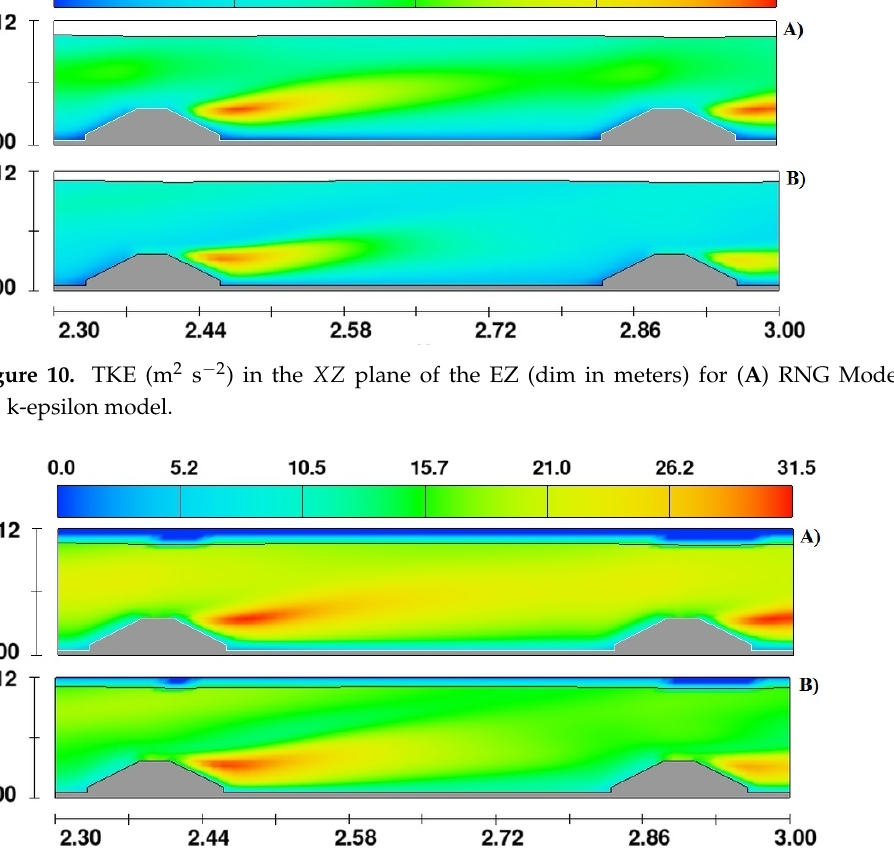
Figure 11. Turbulent Intensities (%) in the XZ plane of the EZ (dim in meters) for ( A ) RNG Model and ( B ) k-epsilon